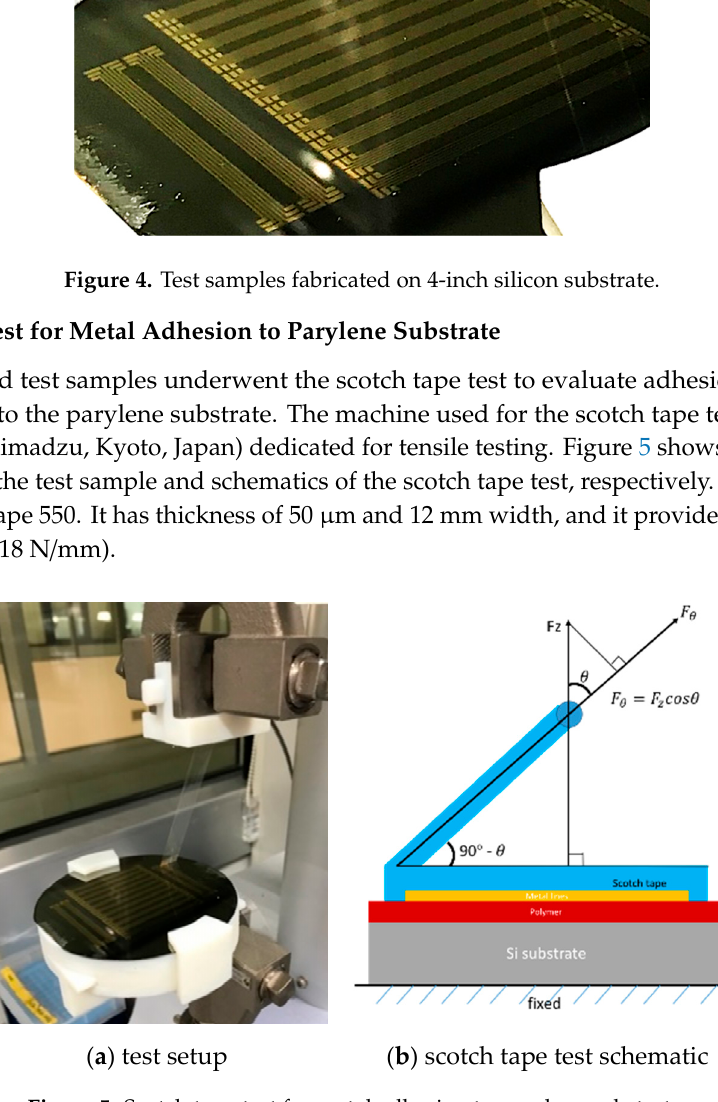
Figure 5. Scotch tape test for metal adhesion to parylene substrates.